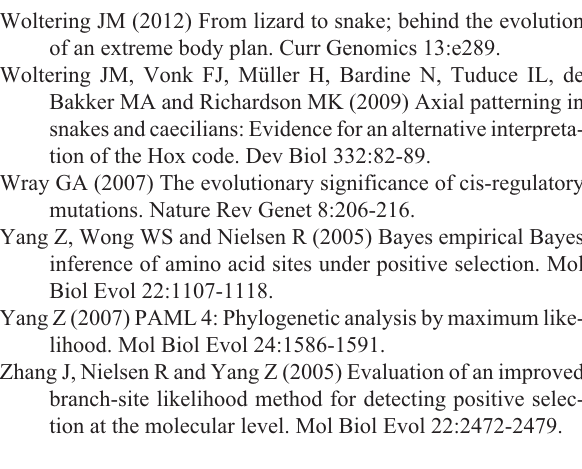
Table S1- List of species used in the bioinformatic analy- ses. Figure S1 - Results from HyPhy analyses in the Data- monkey